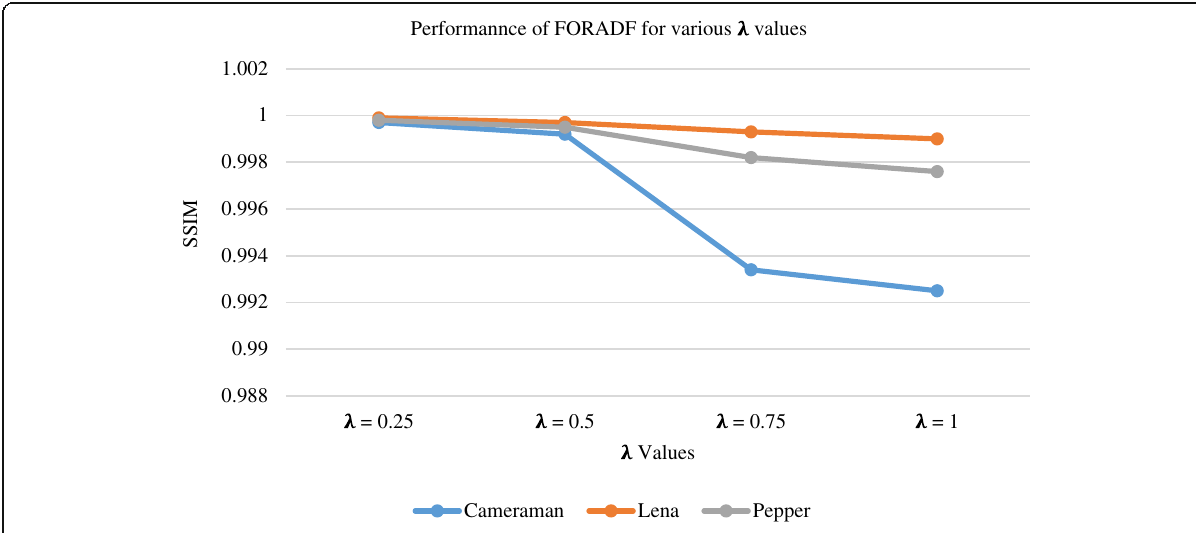
Fig. 11: Performance of FORADF in terms of SSIM for various λ values at 20% salt and pepper noise density for n = 5. λ represents the control parameter, and n represents the number of iterations. The figure shows the stability of FORADF for various λ values, and the performance is measured in terms of the performance metric